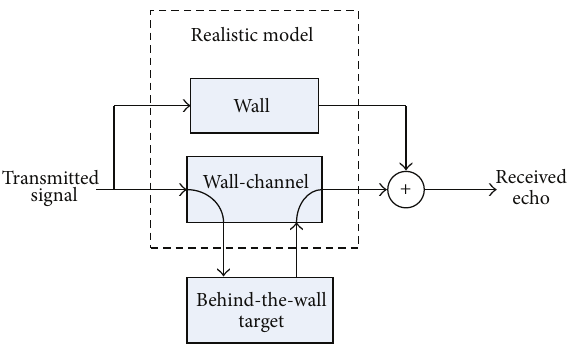
Figure 2: Developed realistic model of